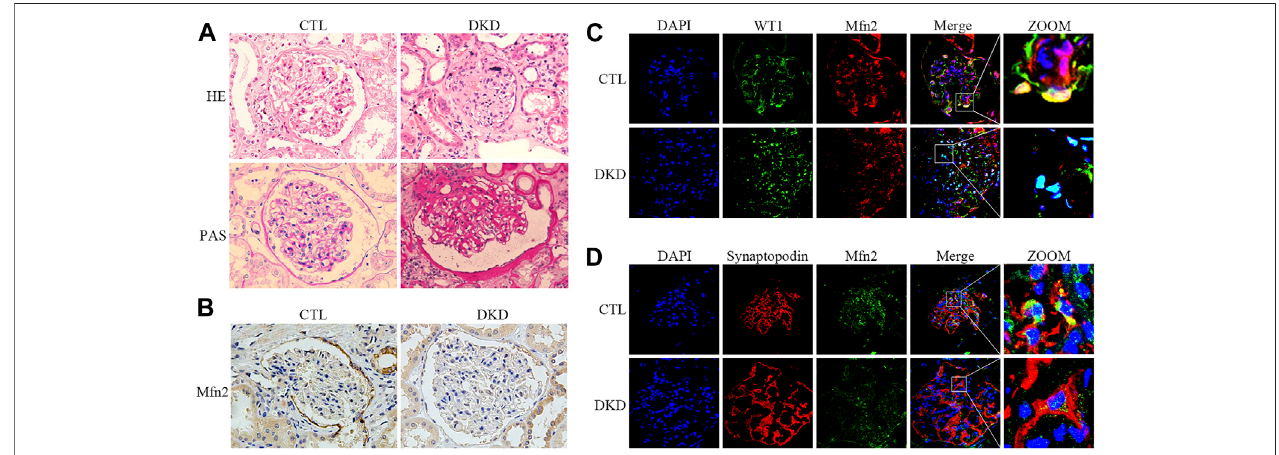
FIGURE 2 | Histopathological changes and Mfn2 expression in patients with DKD. (A) Histological changes in patients with DKD were determined by HE and PAS staining (original magni fi cation, × 400). (B) Representative images of immunohistochemical staining of Mfn2 in glomeruli per group (original magni fi cation, × 400). (C,D) Representative images ofimmuno fl uorescent staining ofMfn2, WT1 or Synaptopodin and DAPI inglomeruli per group (original magni fi cation, × 600). CTL, control; DKD, diabetic kidney disease.